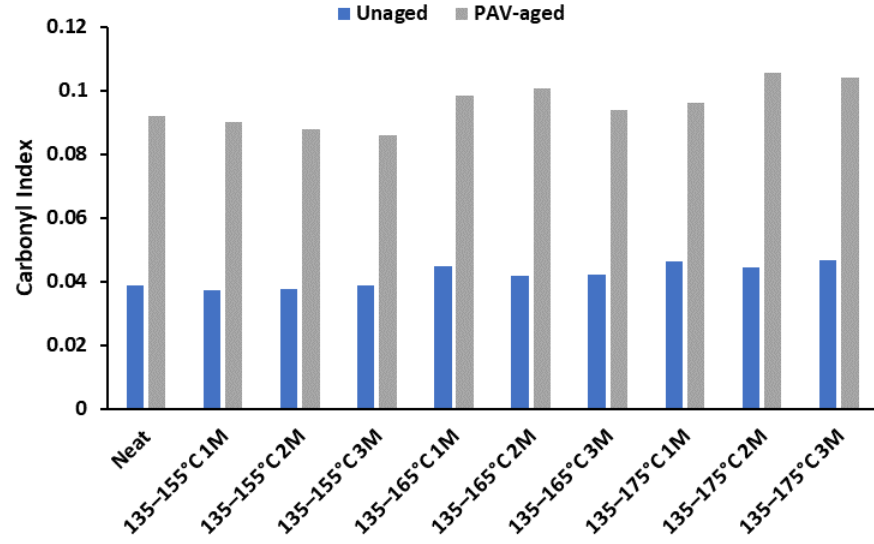
Figure 18. Carbonyl index results at the unaged and PAV-aged stages.